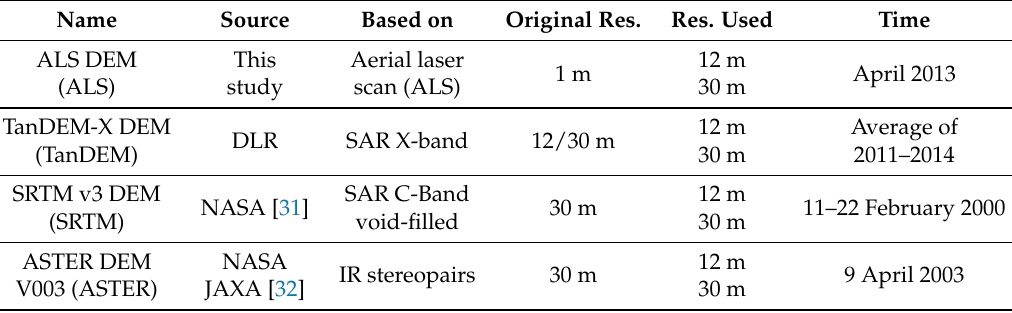
Table 1. Characteristics of the DEMs used in the